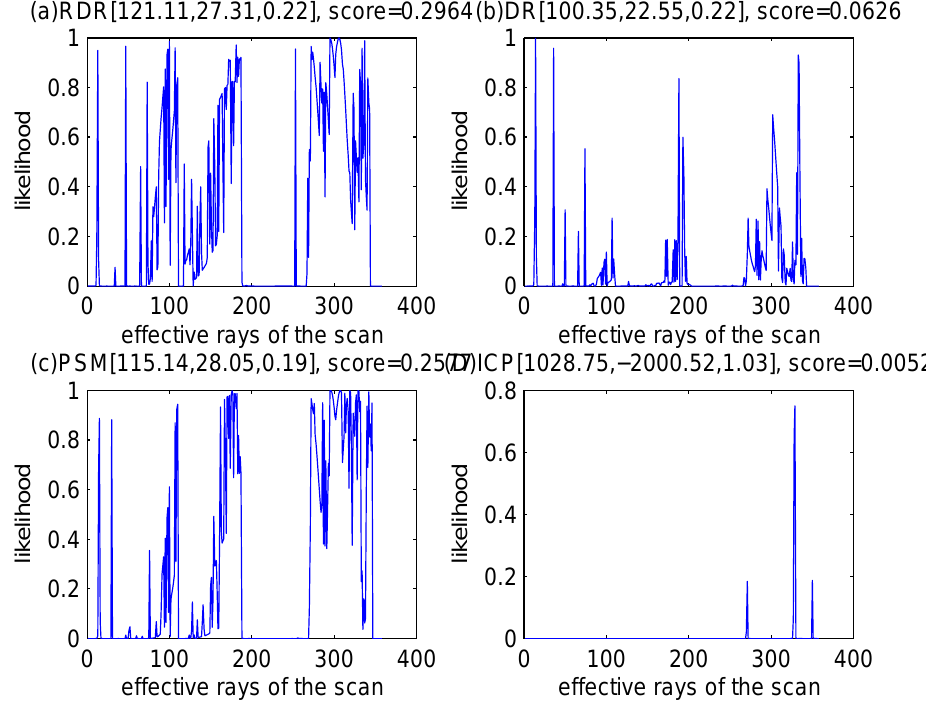
Figure 8. Likelihood of the rays of results of four methods (time Step